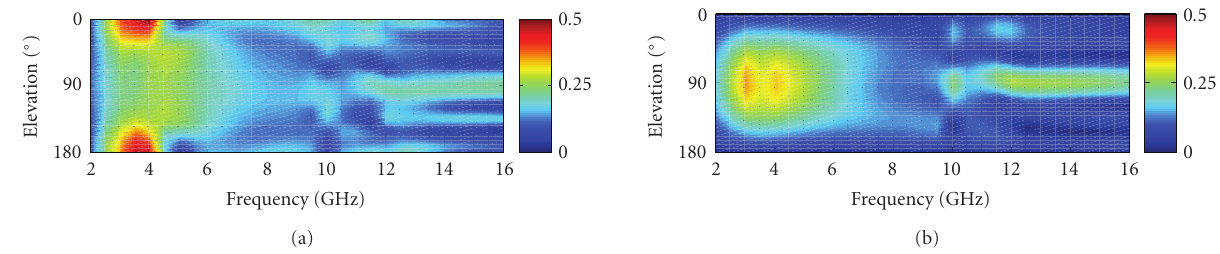
Figure 7: Azimuth-averaged SC modulus of ENSTA bicone antenna ( d = 50mm): (a) exact computation and (b) computation by means of scattered fields.